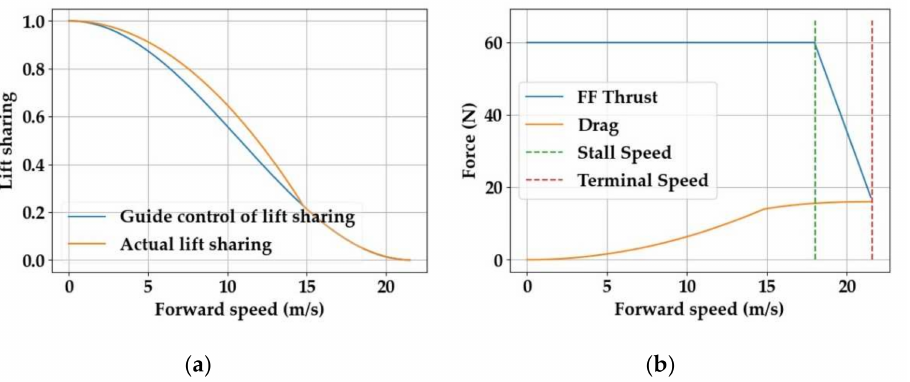
Figure 11. ( a ) An example of lift sharing guide control according to the forward velocity of a UAV during transition mode. ( b ) An example of forward thrust and drag according to the forward velocity of a UAV during transition